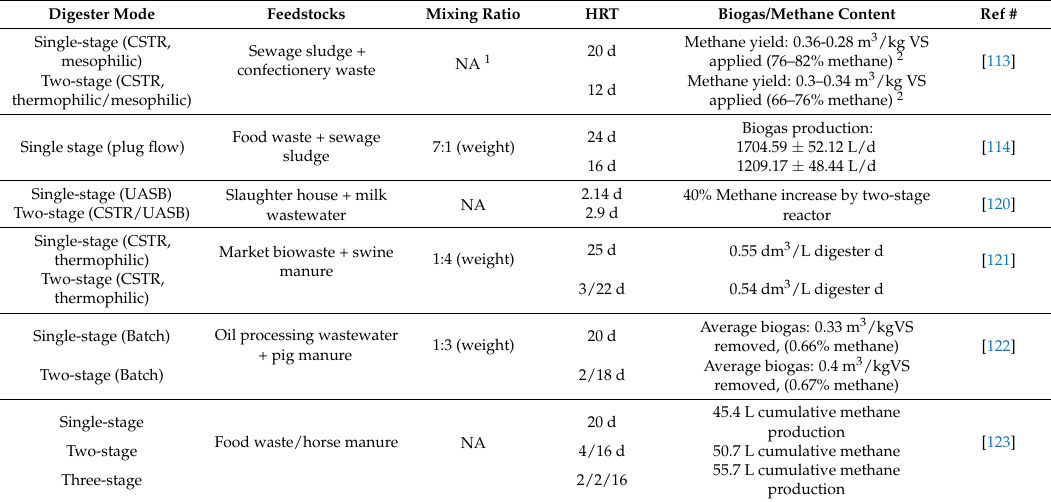
Table 3. Comparison of single-stage and two-stage digestion in AnCoD